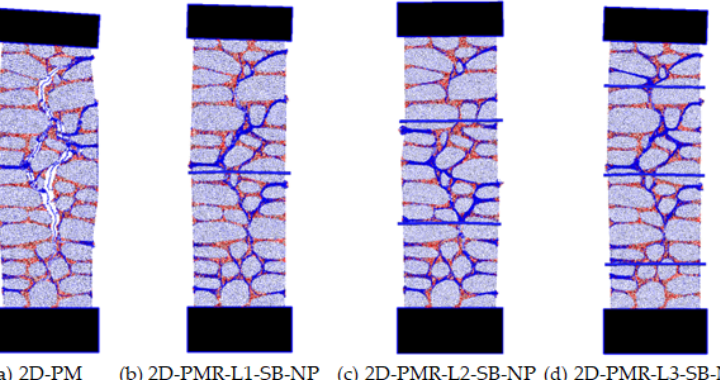
Figure 19. Contact damage distribution of the numerical models: URM and RM models with a strong bond without a lateral